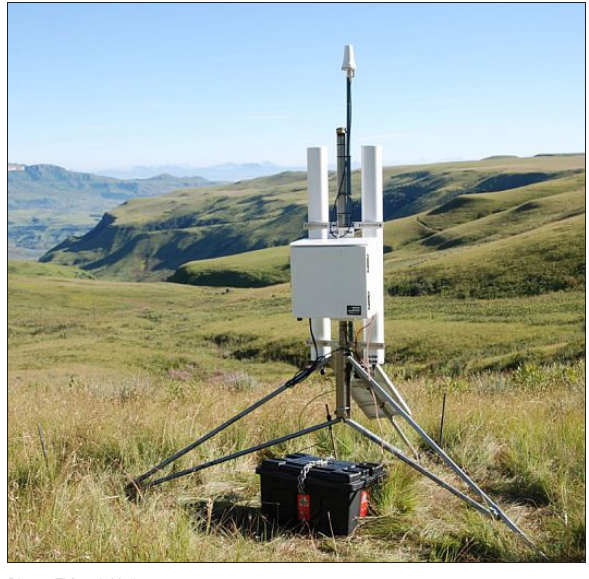
Photo: Thigesh Vather Figure 2: The cosmic ray probe in Cathedral Peak Catchment VI. The calibration procedure involves obtaining an estimate of the area- averaged soil moisture content over the CRP measurement footprint by gravimetric sampling and the subsequent neutron intensity. Soil samples were taken at three radial rings, extending outwards from the CRP. The radial rings were situated at distances of 25 m, 100 m and 200 m from the CRP (Figure 3). At each of the three rings, eight points were taken at an equal distance along the circumference of the ring. At each sample point, soil samples were taken at different depths.